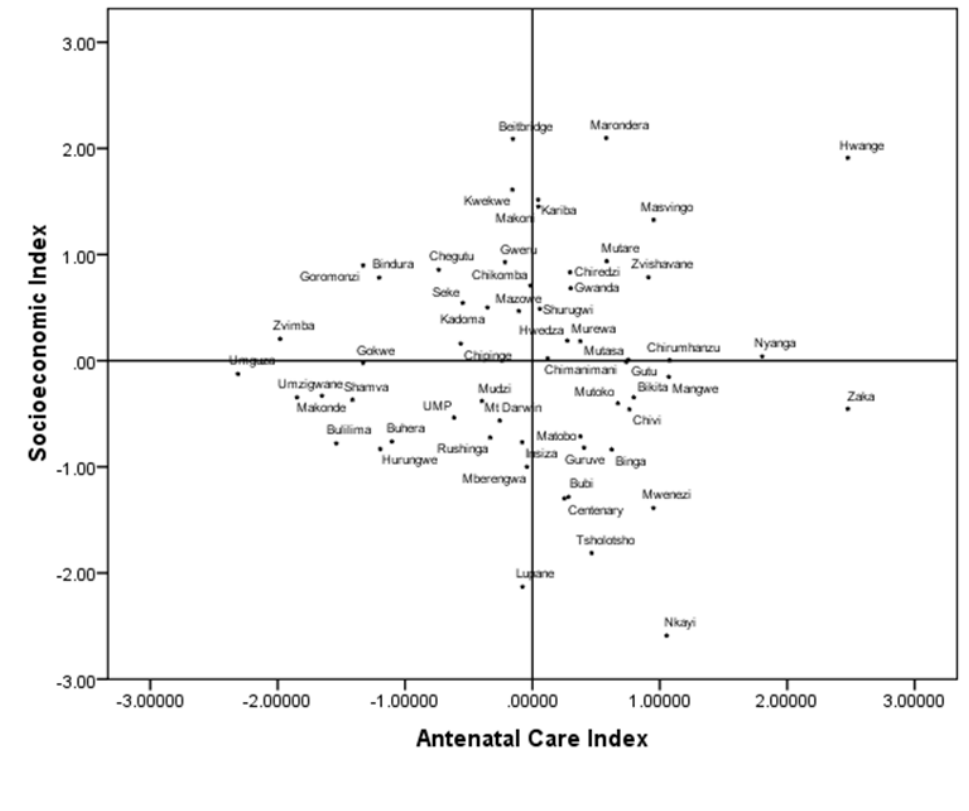
Figure 5. Scatterplot of Socioeconomic Index and Antenatal Care